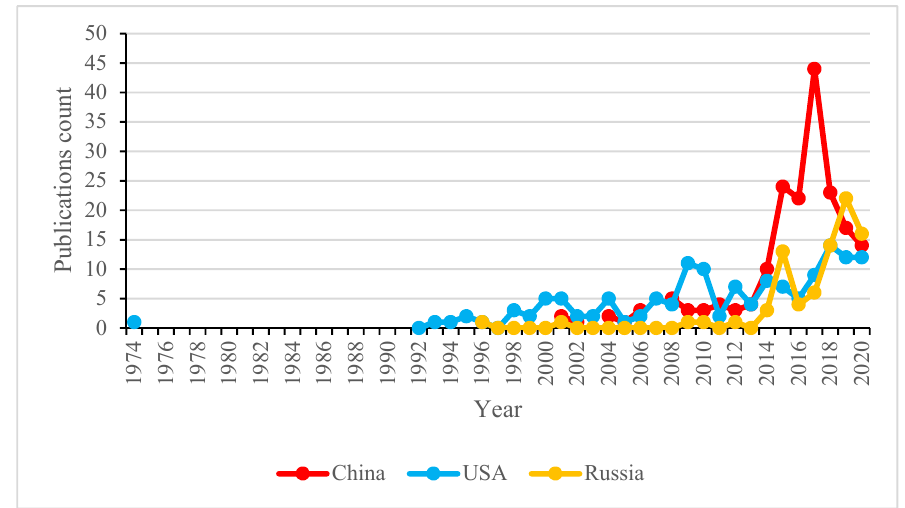
Figure 8. FTZ publications among the top 3 countries.